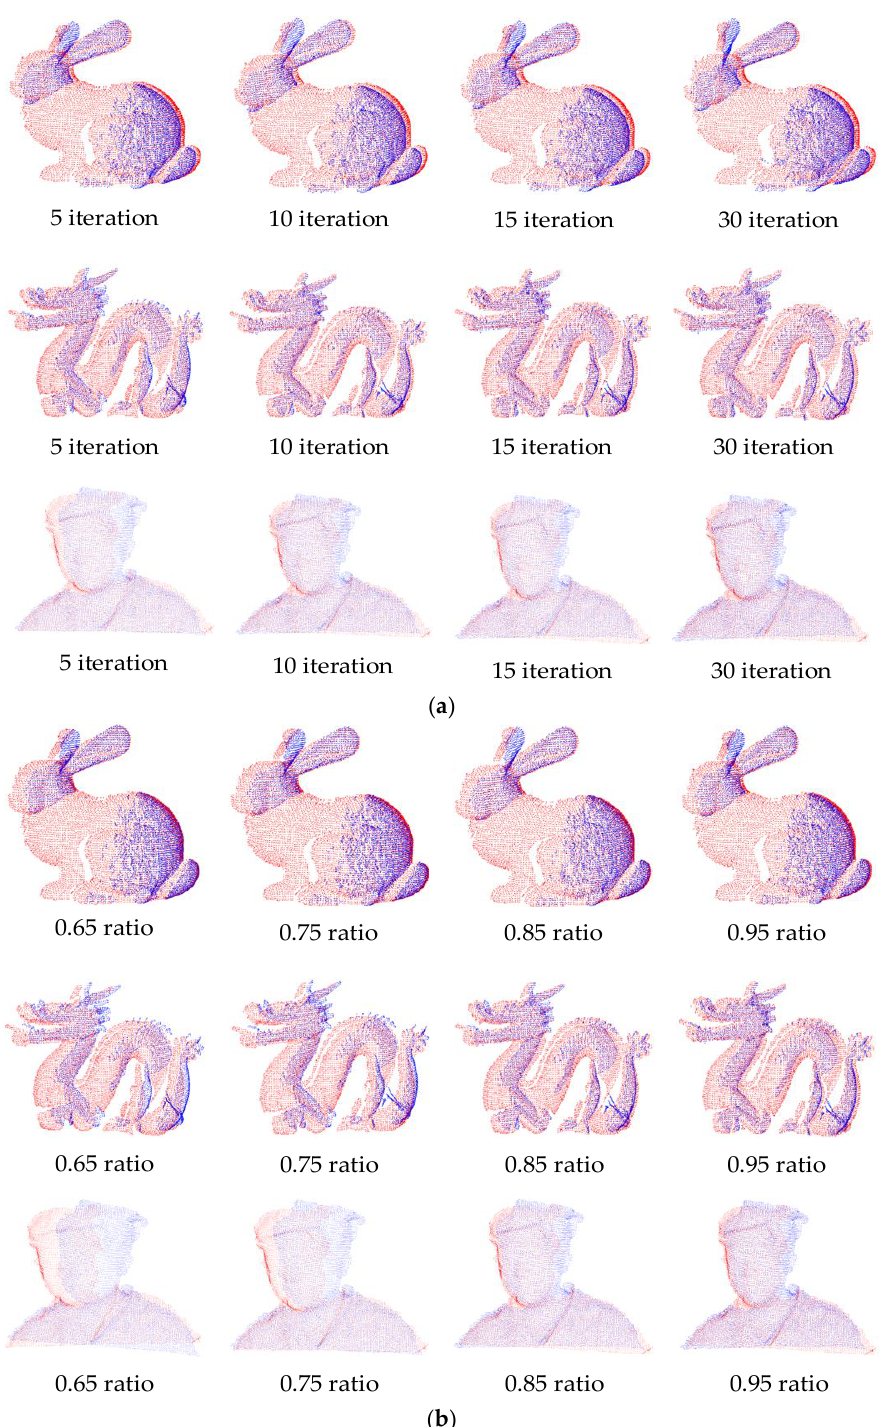
Figure 7. The registration results of bunny rabbit, dragon and scanned face with coarse-to-ICP and coarse-to-TrICP. ( a ) Three group data registration results of coarse-to-ICP with 5, 10, 15 and 30 iteration times of ICP. ( b ) Three group data registration results of coarse-to-TrICP with 0.65, 0.75, 0.85 and 0.95 overlap ratio of TrICP.